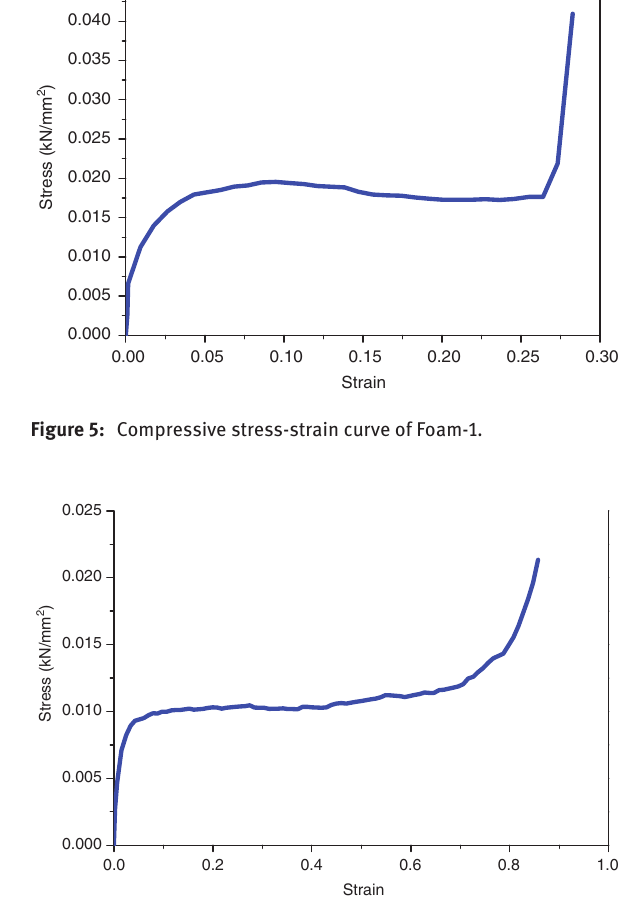
Figure 6: Compressive stress-strain curve of Foam-2.